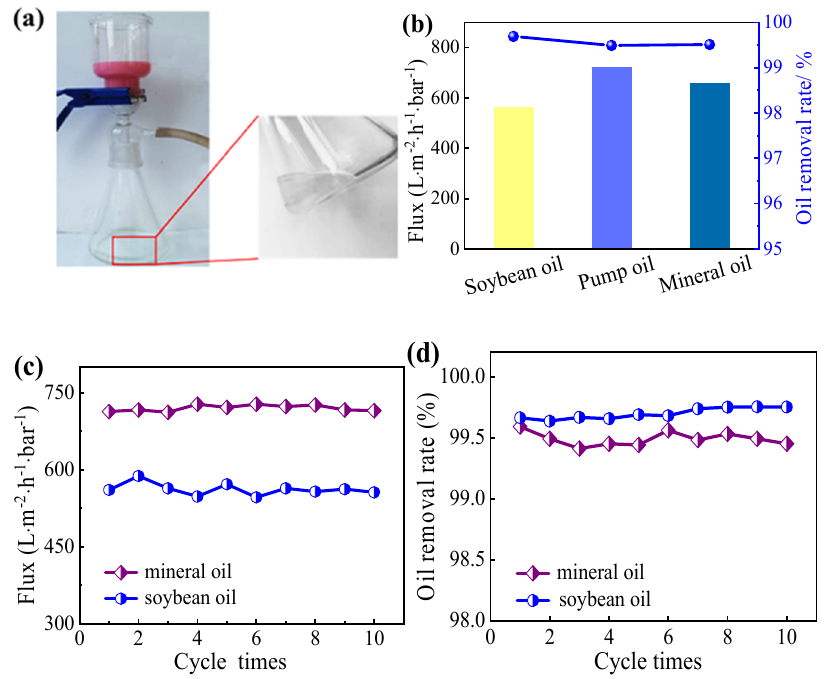
Figure 6. ( a ) Oil/water separation experimental device of the NCM, ( b ) flux and oil removal rate of the SDS-stabilized oil-in-water emulsions (soya-bean oil, mineral oil and pump oil), ( c ) flux changes of emulsified soybean oil and pump oil for 10 filtration cycles, ( d ) oil removal rate changes of emulsified soybean oil and pump oil for 10 filtration cycles.